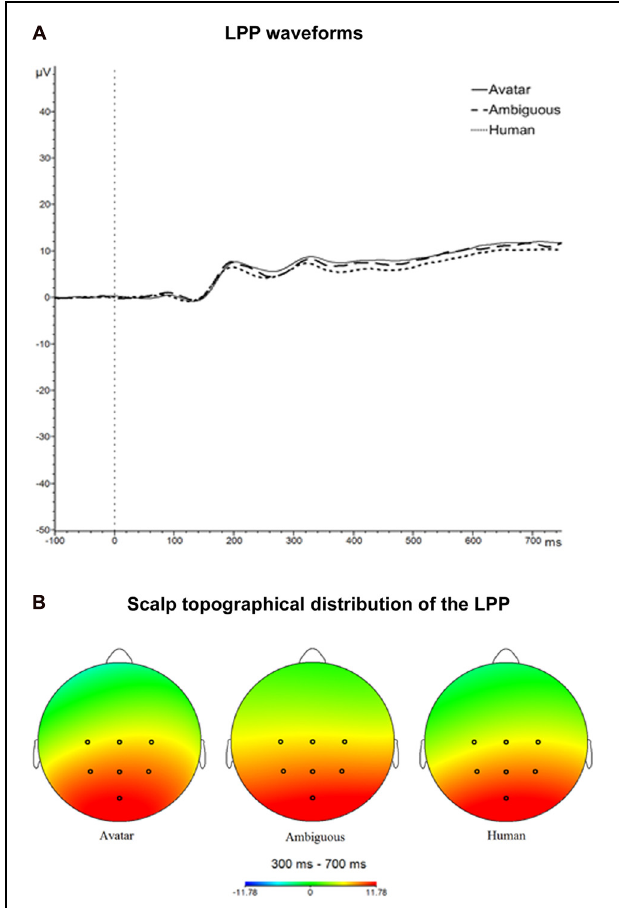
FIGURE 4 | Late positive potential (LPP) waveforms and scalp topographical distribution. The figure illustrates the LPP waveforms (A) and the scalp topographical distribution of the LPP (B) for avatar faces, ambiguous faces and human faces.